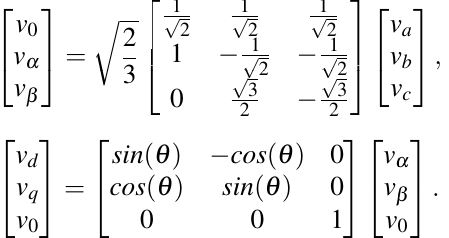
calculationPI controller Grid code